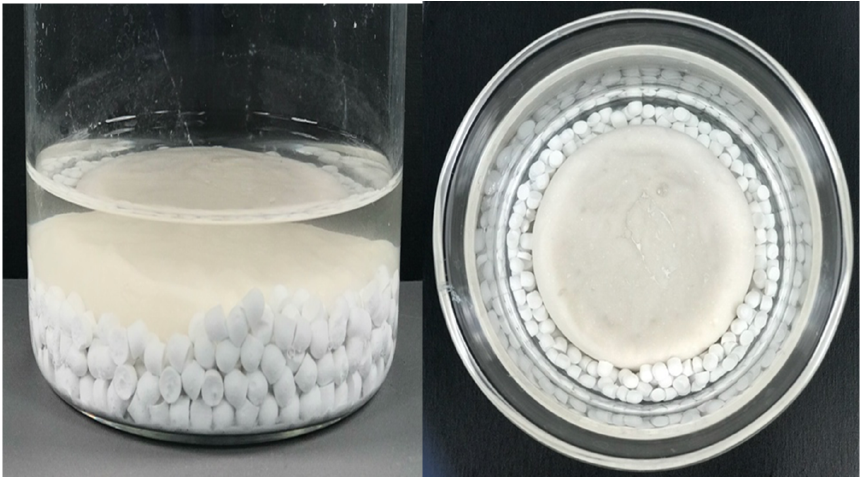
Figure 2. Representative images of calcium sulfate beads within the reactor system after 48 h.